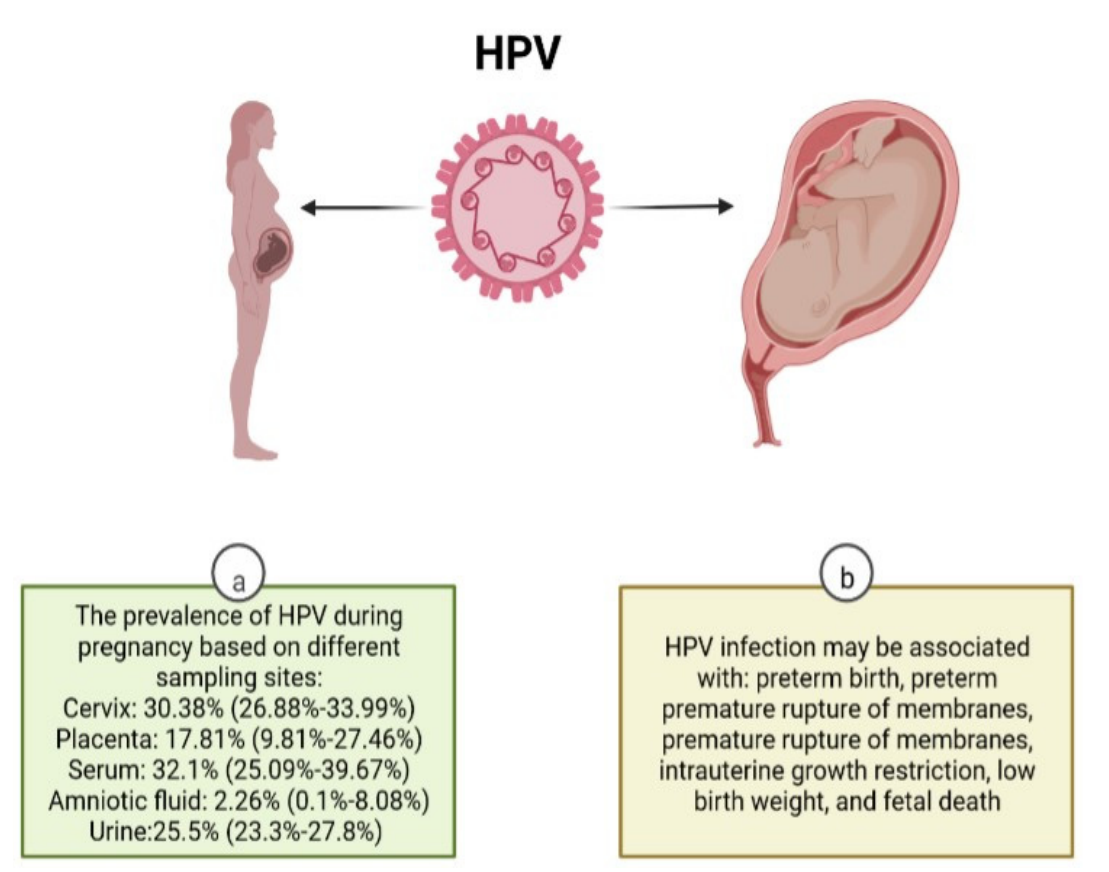
Figure 1. Manifestations of HPV in pregnancy. ( a ) Information adapted from Ardekani et al. [5]. ( b ) Information adapted from Niyibizy et al. [6]. Created with BioRender.com, accessed on 6 July 2022.